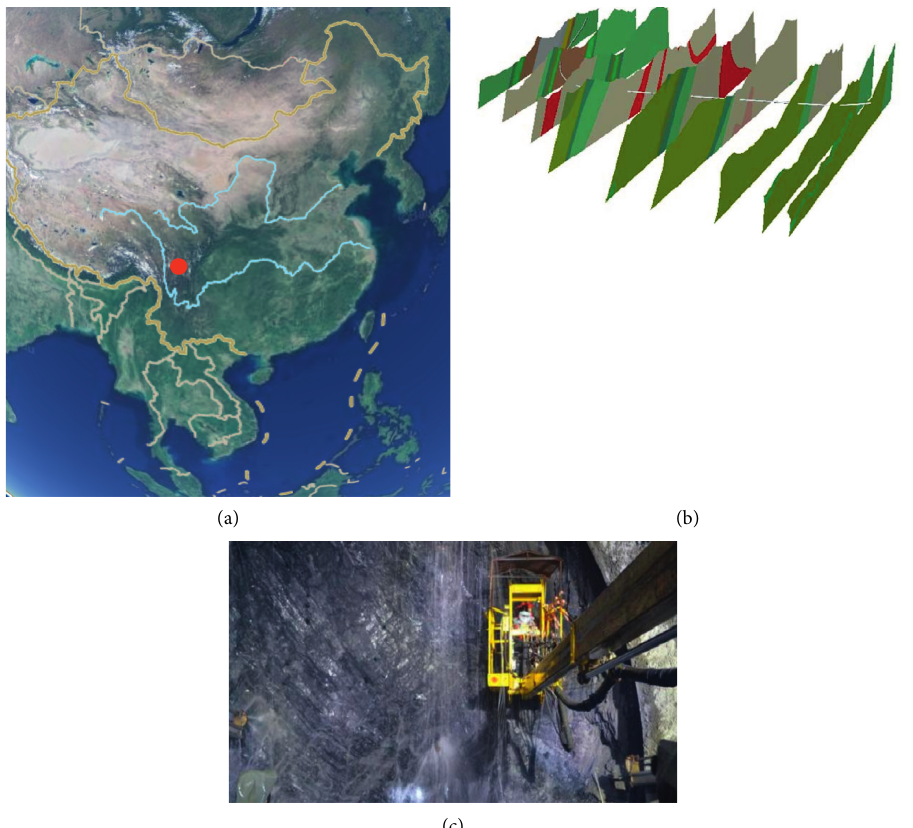
Figure 1: Engineering geological characteristics of Yuelongmen deep buried tunnel: (a) tunnel location; (b) tunnel crossing stratum; (c) characteristics of surrounding rock.